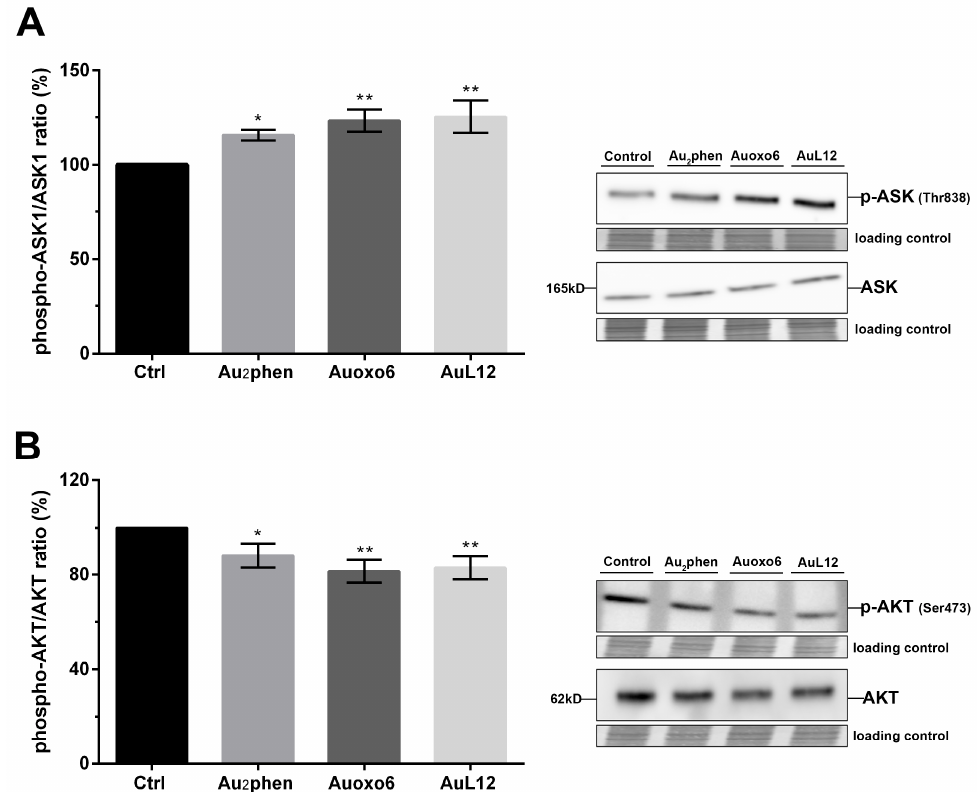
Figure 6. Contributions of ASK1 and AKT in gold(III)-induced apoptotic signaling. A2780 cells were treated for 24 h with Au 2 phen, Auoxo6, and AuL12 72 h IC 50 doses. The phosphorylation levels and total protein amounts of ( A ) ASK1 and ( B ) AKT were analyzed through Western blotting. Histograms report the percentages of normalized mean values ± SD of the phospho-ASK1/total ASK1 ratio and phospho-AKT/total AKT ratio compared to controls. The phospho- ASK1/total ASK1 and phospho-AKT/total AKT ratios were obtained from the normalized relative integrated density values of immunostained bands of three independent Western blots. Representative immunoblots are also shown together with the matching Coomassie-stained PVDF membranes, which were used as loading control. Original Western blot images of ASK1 and AKT phosphorylation level and of their total amount are reported in Figures S6 and S7. The statistical analysis was carried out using one-way ANOVA test followed by Tukey’s multiple comparisons test using GraphPad Prism software v 6.0 (* p < 0.05, ** p <